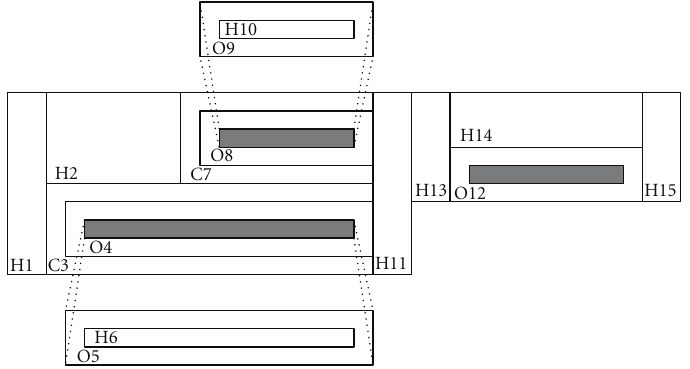
Figure 4: Stage mesh topology.